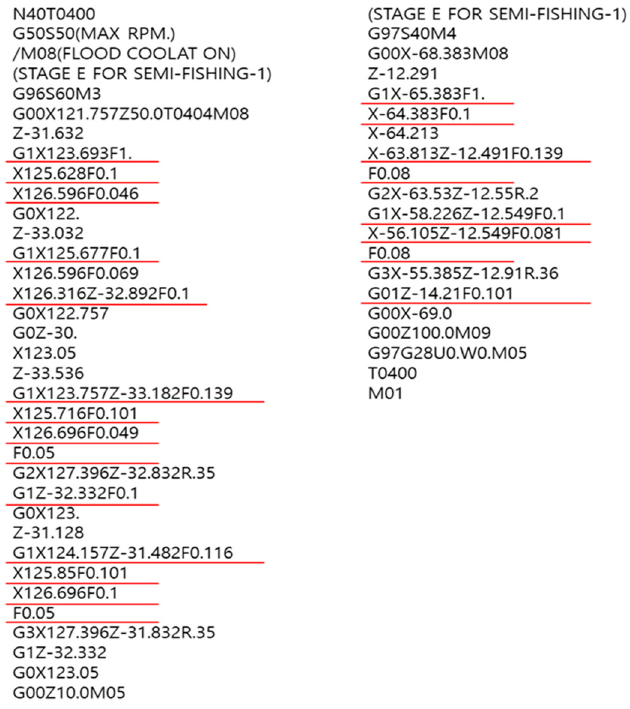
Figure 5. Generated NC code for T04.